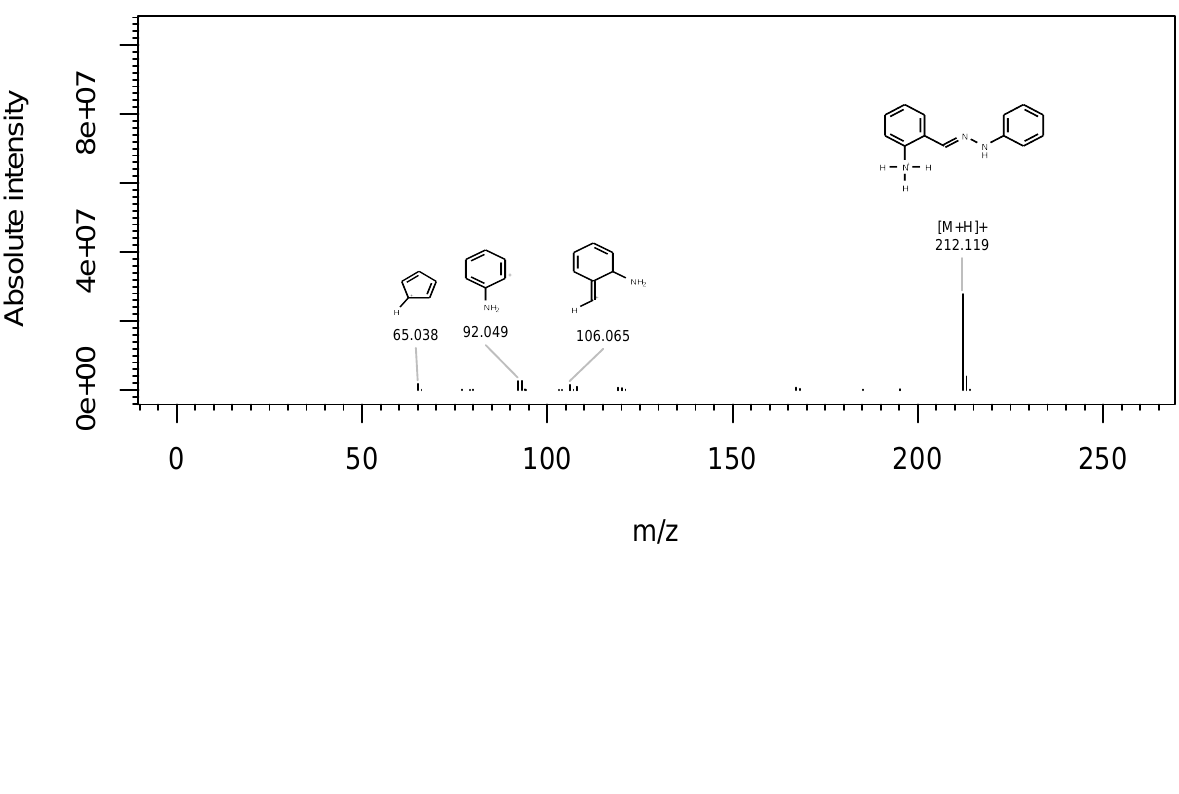
Figure A14. Challenge 17: annotated merged MS and MS/MS spectra of nitrin (ESI, positive